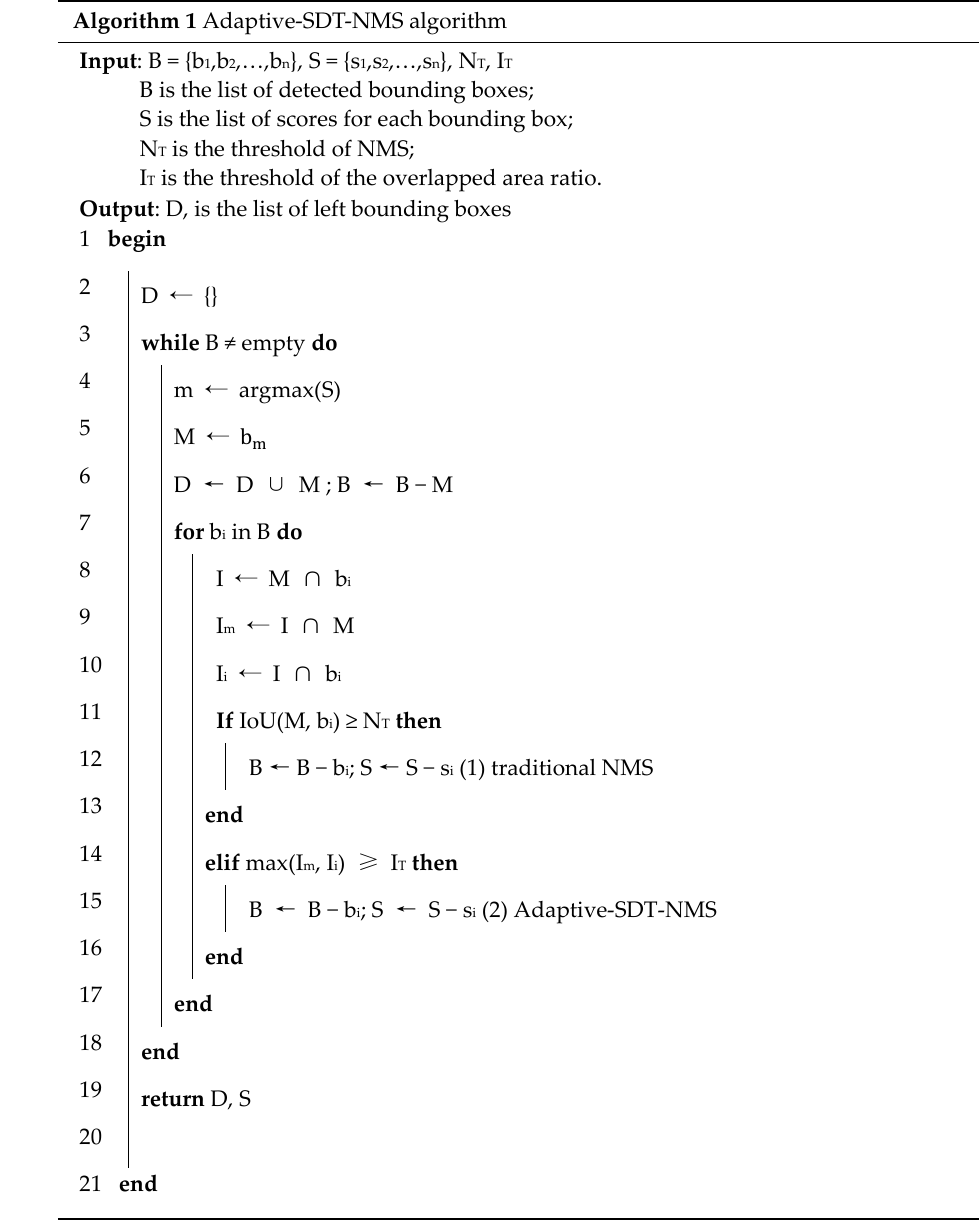
Algorithm 1 Adaptive-SDT-NMS algorithm